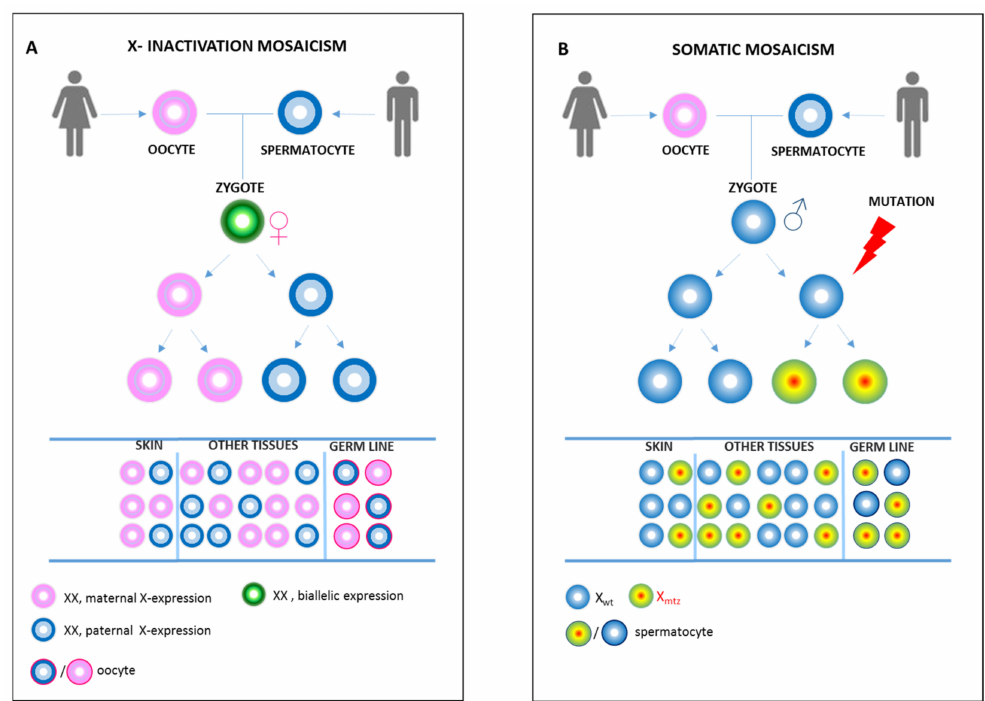
Figure 1. X-inactivation mosaicism or somatic mosaicism. ( A ) X-chromosome inactivation in fe- males is a random event. Once the choice for the inactivation of either the maternal or paternal X-chromosome is made, it is stably inherited by all daughter cells. Therefore, the females are physio- logical mosaic. The extent of mosaicism in each tissue is made up by selection of cells expressing paternal or maternal X chromosome. This determines a phenotypic condition indistinguishable from the somatic mosaicism in ( B ). An early post-zygotic mutation (X mtz) causes the mosaicism in most or all tissues of the body (including skin, germline, and other tissues), with only a portion of cells in each tissue harboring the